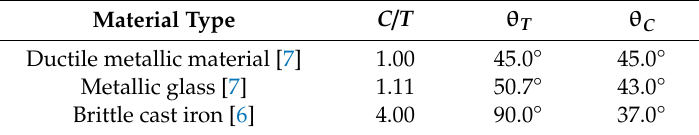
Table 1. Strength parameters of three di ff erent types of isotropic metals.